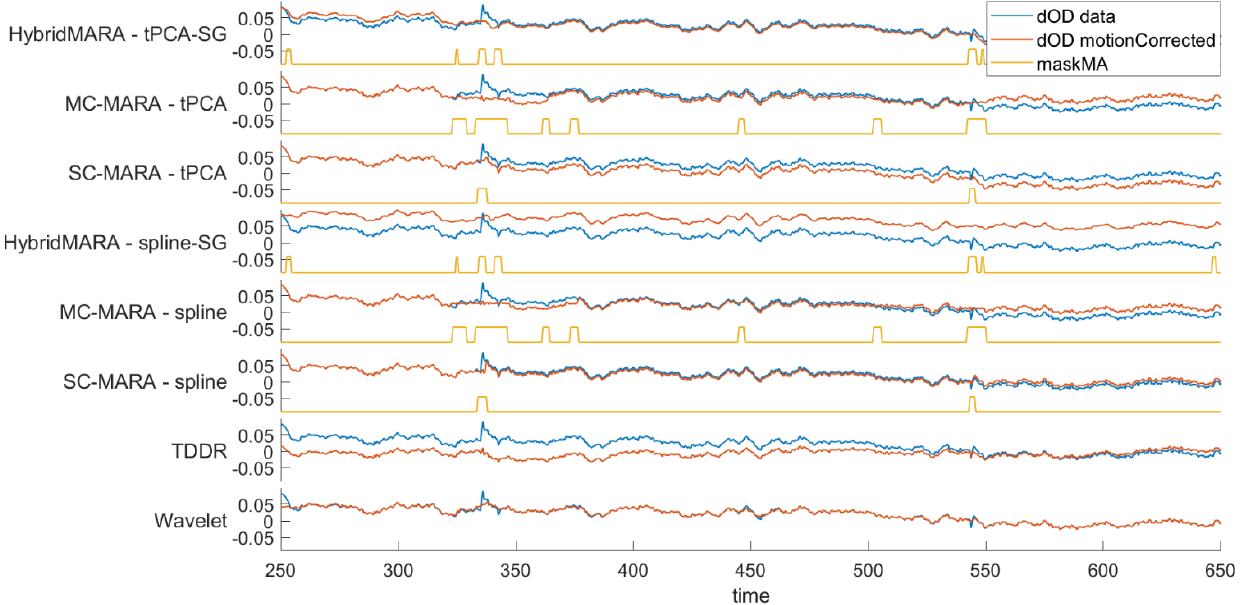
Figure 4. Single-channel graphical representation of the effect of MA reduction over Δ𝑂𝐷 signals across pipelines. Δ𝑂𝐷 signals are represented with respect to the unprocessed signal (blue line-input signal) and after MA reduction (red line-output signal). Additionally, signal tracts labelled as MAs are presented as squared waves (yellow line).